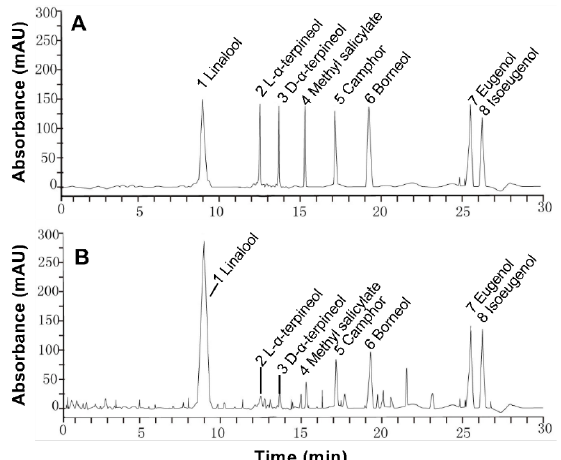
Figure 1. High performance liquid chromatogram of 100 µ g / L mixed standard solution ( A ) and 500 µ g / L